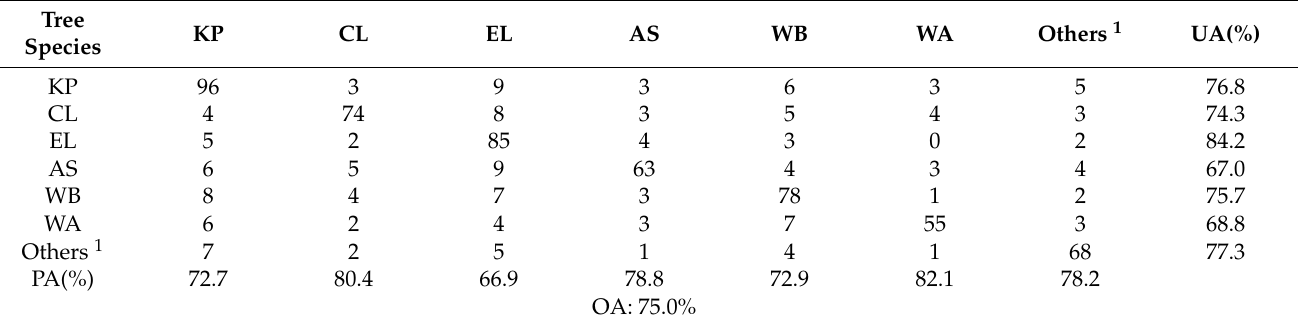
Table 7. Confusion matrix of the classification results with SG (CNN) classifier based on WorldView-3 + ALS